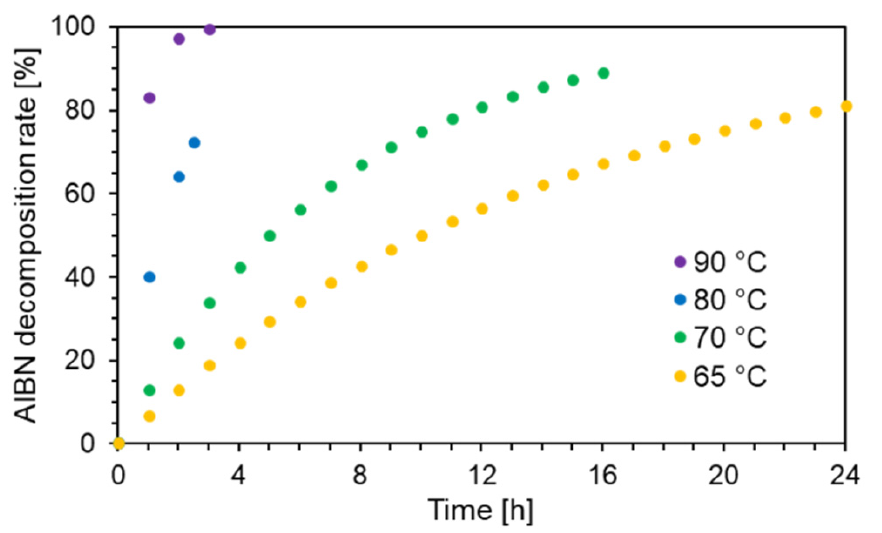
Figure 2. Calculated time-decomposition rate for AIBN.